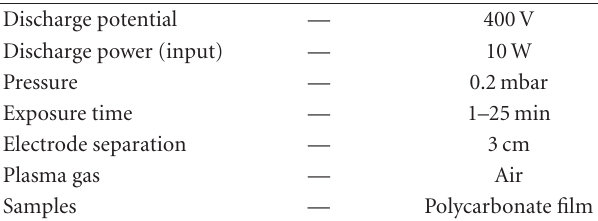
Table 1: Operating parameters for plasma processing. Table 2: Surface energy of